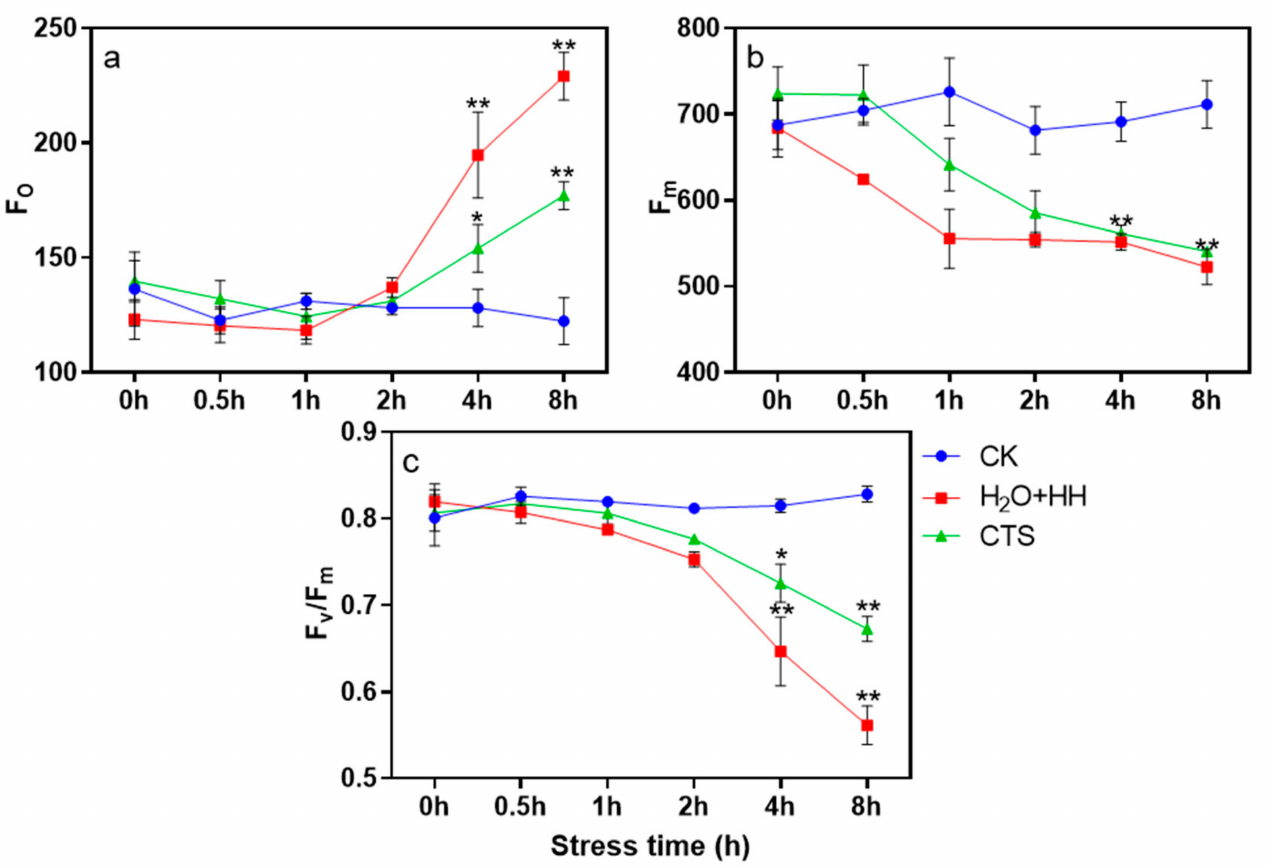
Figure 3. Effect of CTS on the PSII photoinhibition of strawberry seedlings under high-temperature and high-light stress. ( a ) initial fluorescence, F o ; ( b ) maximum fluorescence, F m ; ( c ) maximum photochemical efficiency, F v /F m . CK: H 2 O + 23 ◦ C + 400 µ mol · m − 2 · s − 1 ; H 2 O + HH: H 2 O + 38 ◦ C + 1800 µ mol · m − 2 · s − 1 ; CTS + HH: CTS + 38 ◦ C + 1800 µ mol · m − 2 · s − 1 . * indicates that there is a significant difference between treatments (Duncan’s multiple range test; p < 0.05); and **, a very significant difference